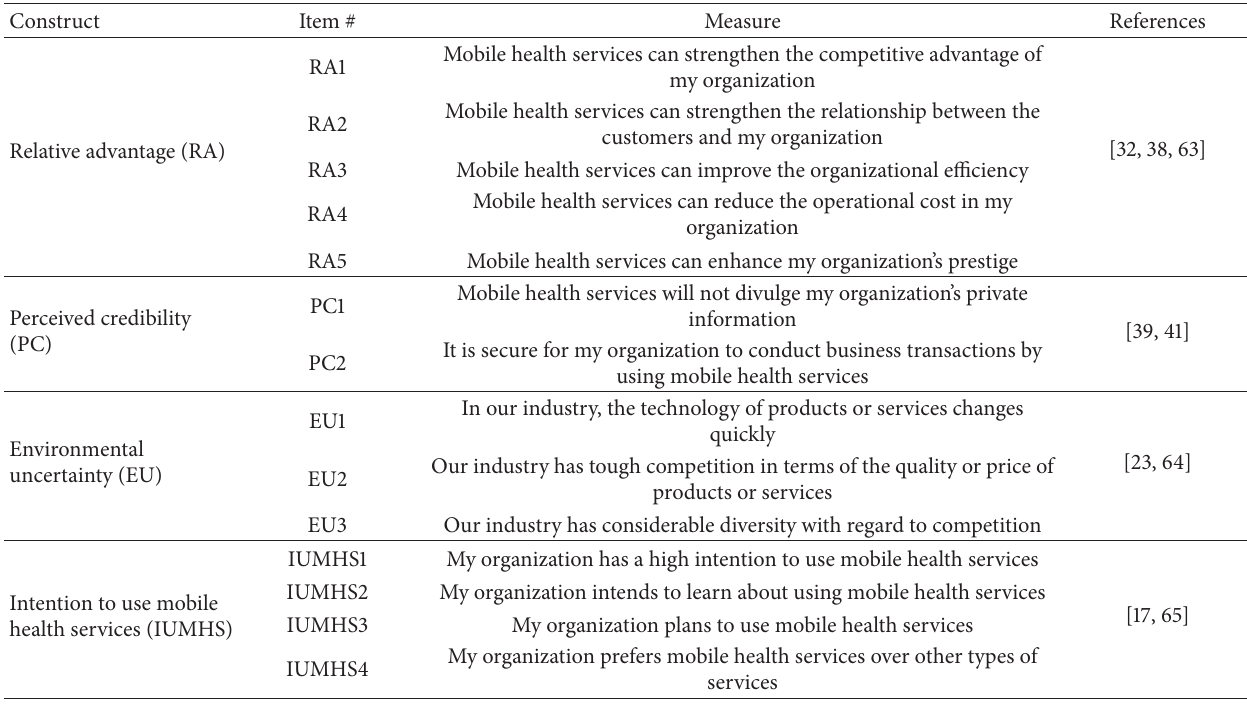
Table 3: Constructs and measures.